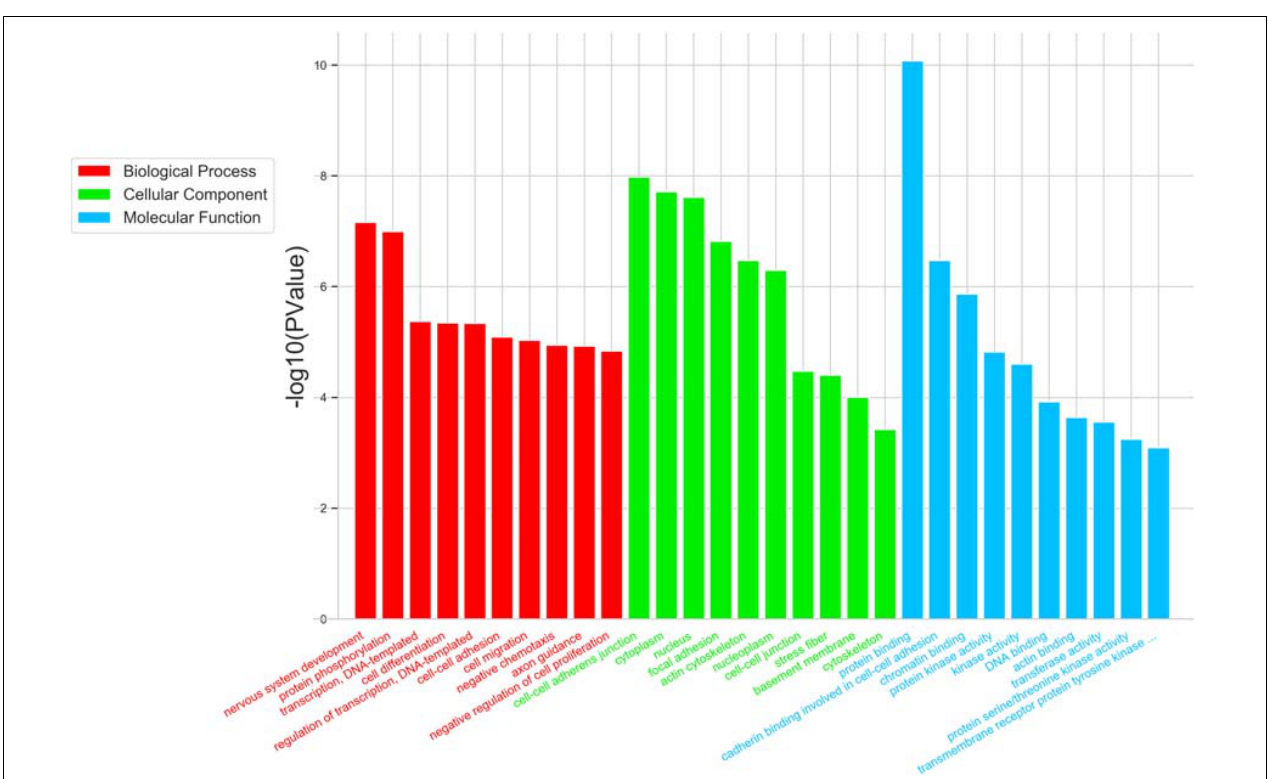
FIGURE 5 | Top 10 significantly enriched GO terms of the overlapping target genes of common differentially expressed miRNAs were depicted in the three virus infected groups. GO analysis showed that the intersectional putative target genes of common miRNAs were involved in three parts of GO terms: Biological Process (Red), Cellular Component (Green), and Molecular Function (Blue). The expression trend of putative target genes involved in this GO term is inversely related to the expression of their targeting